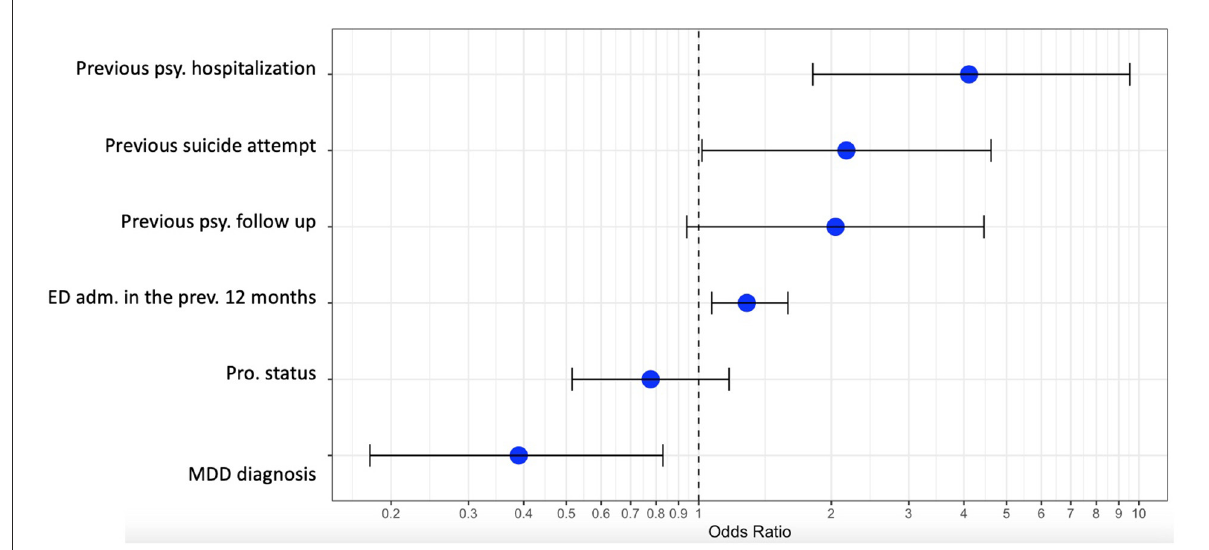
FIGURE2 Multimodal regression analysis. Previous psy. hospitalization, previous psychiatric hospitalization; previous psy follow up, previous psychiatric follow up; ED adm. in the previous 12 months, ED admission in the previous 12 months; pro. status, professional status; MDD diagnosis, major depressive disorder